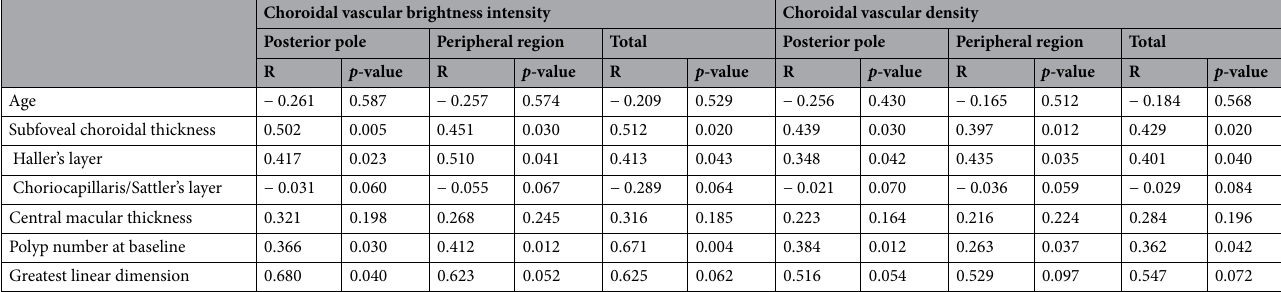
Table 5. Pearson correlation analysis of choroidal vascular features and associated factors. CVB choroidal vascular brightness, CVD choroidal vascular density, SFCT subfoveal choroidal thickness.